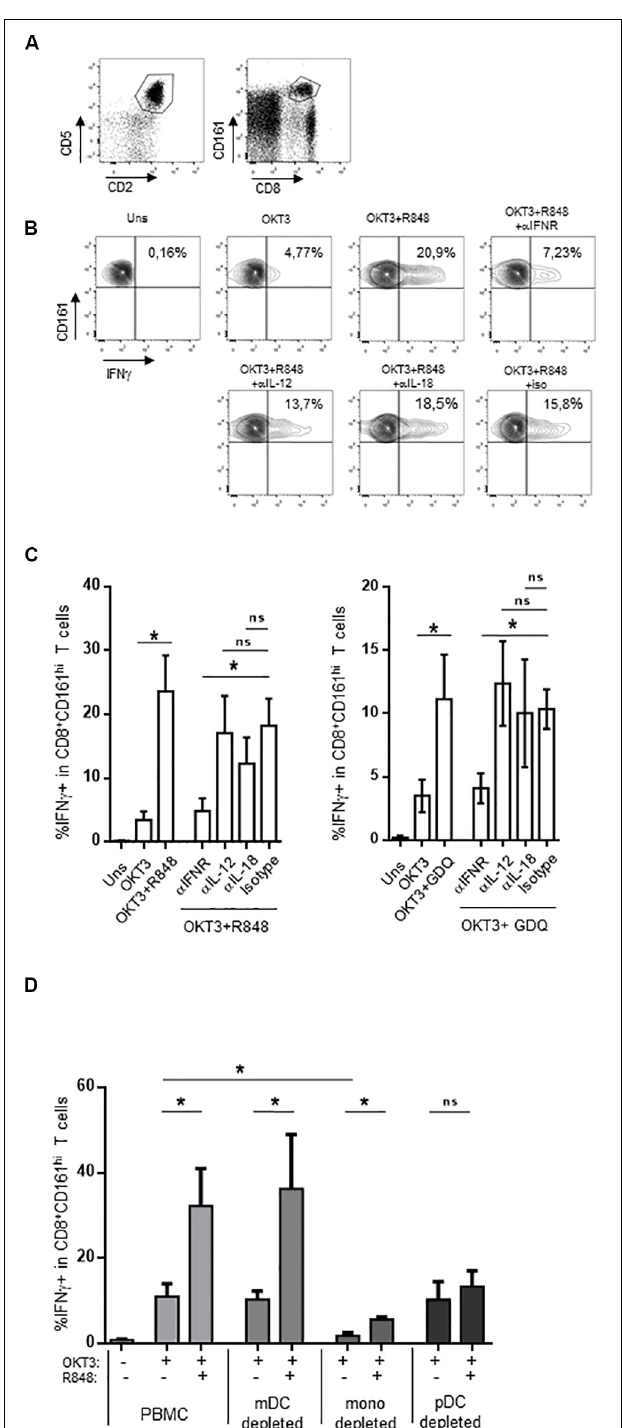
FIGURE 1 | CD161 hi CD8 + T cell activation by TLR7/8 ligands. (A) Gating strategy, based on T cell gating as CD5 + CD2 + lymphocytes (left panel), followed by identification as CD161 hi CD8 + cells within the CD5 + CD2 + subset. (B,C) PBMC were rested or incubated for 16 h with the indicated reagents, in the presence of brefeldin A, before cell surface staining, fixation, permeabilization, and intracellular staining with anti-IFN γ